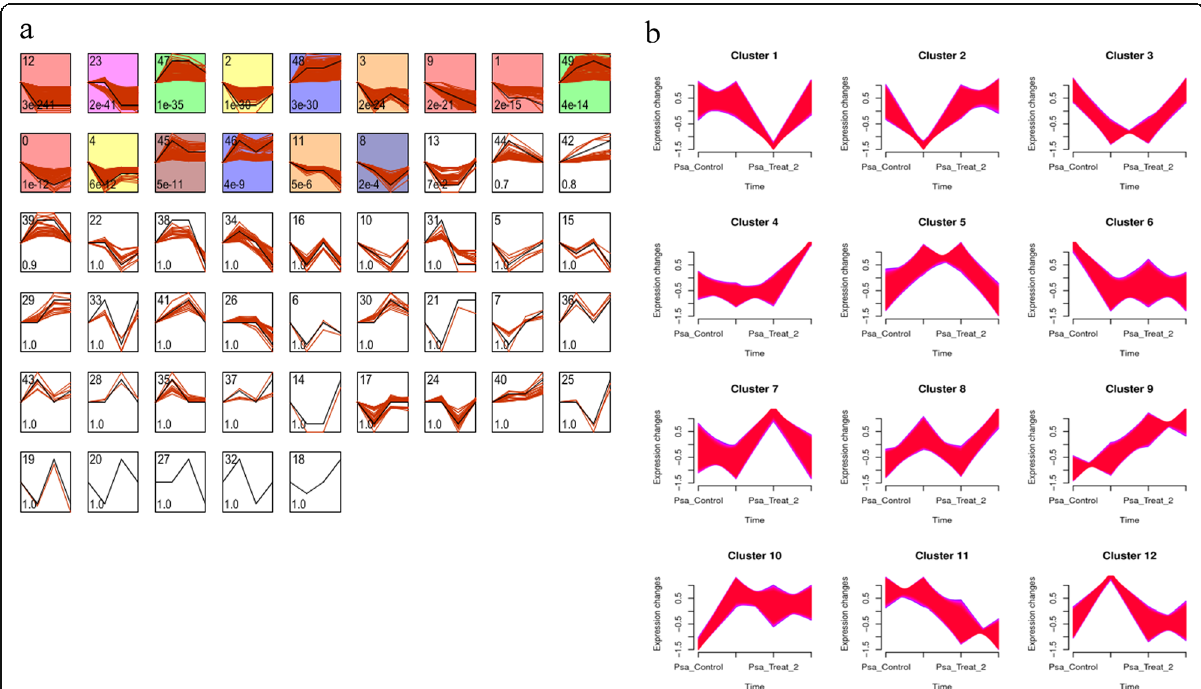
Fig. 5 Clustering analysis of the major expression trends of DEGs and all detective genes. a The expression trends of fifty DEG clusters obtained using STEM software. The profiles are ordered based on the number of significant p -values assigned to the DEGs ( P ≤ 0.05). The top number represents the number of DEGs in each cluster, and the bottom number represents the p-value. b The expression trends of all detective genes with the increase of inoculation time. All genes were assigned to 12 clusters using R package “ Mfuzz ” . The X-axis represents the period of inoculation, and the Y-axis represents the expression level of